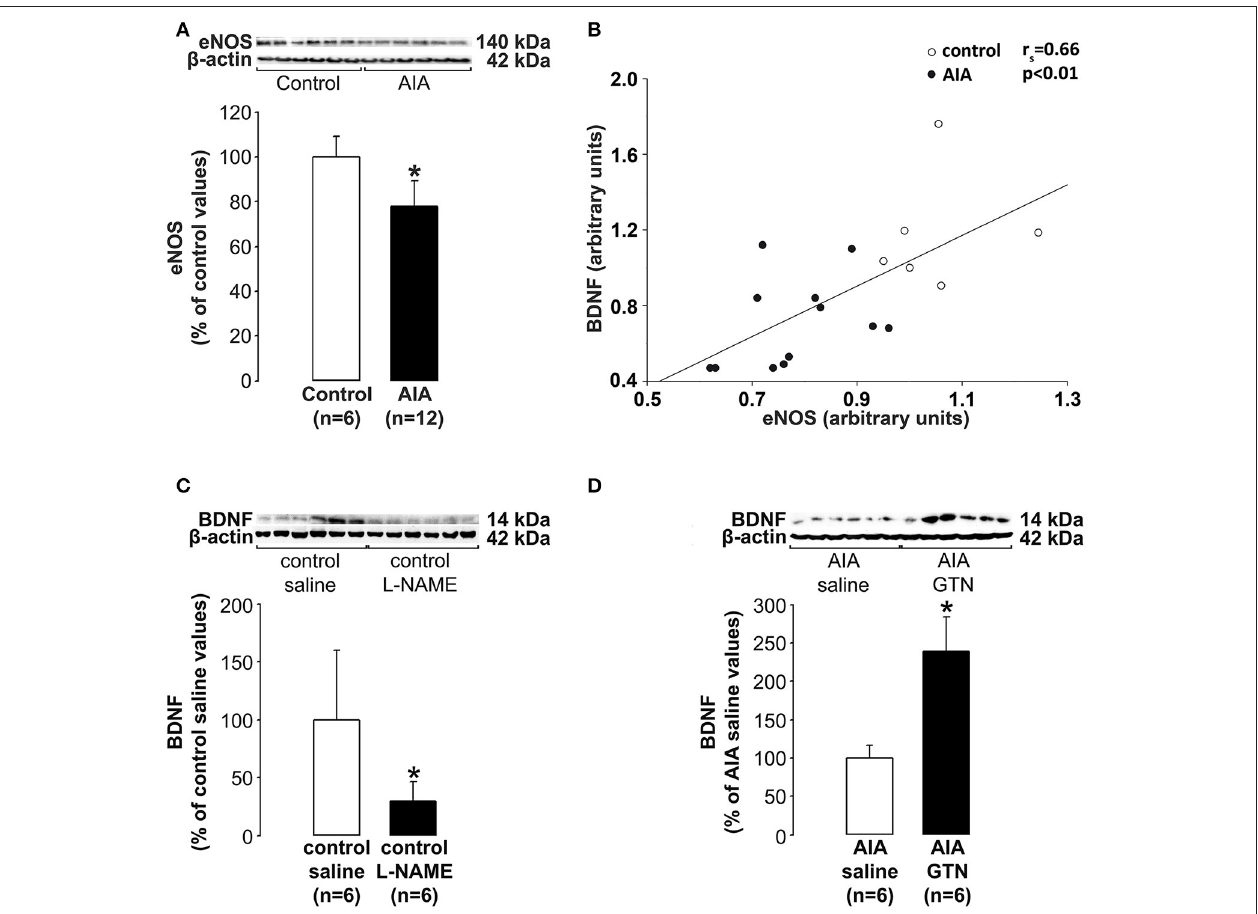
FIGURE 4 | (A) Effect of AIA on eNOS levels in cerebral microvessels-enriched fractions. A representative immunoblot of eNOS and β -actin as internal control is shown above the bar graphs, (B) In these fractions, eNOS and BDNF levels correlated, (C) Effect of the exposure of cerebral microvessels-enriched fractions collected in control rats to N w -nitro-L-arginine methyl ester hydrochloride (L-NAME) on BDNF levels, (D) Effect of the exposure of cerebral microvessels-enriched fractions collected in AIA rats to glyceryl-trinitrate (GTN) on BDNF levels. Vascular samples were collected at day 31 ± 2 post-immunization. Values are expressed as means ± SD, n = number of rats, * p < 0.05 vs. corresponding